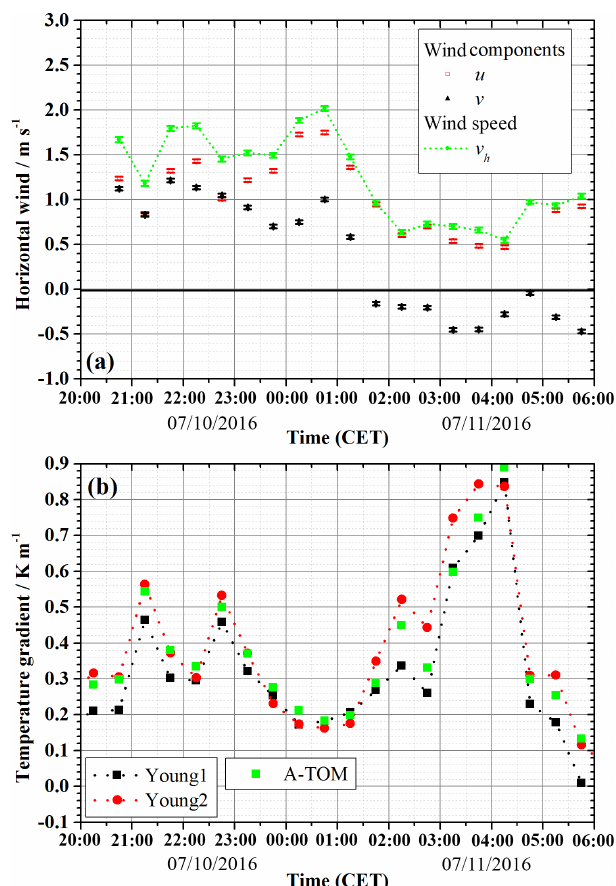
Figure 13. Averaged (30min) data: (a) horizontal wind speed at a height of 1.5m measured by A-TOM and with maximum uncertain- ties; (b) vertical gradient (3–1.5m) of acoustic virtual temperature measured by sonic anemometers (Young1–2 see Fig. 1) and by A- TOM as spatial mean (50 × 50m 2